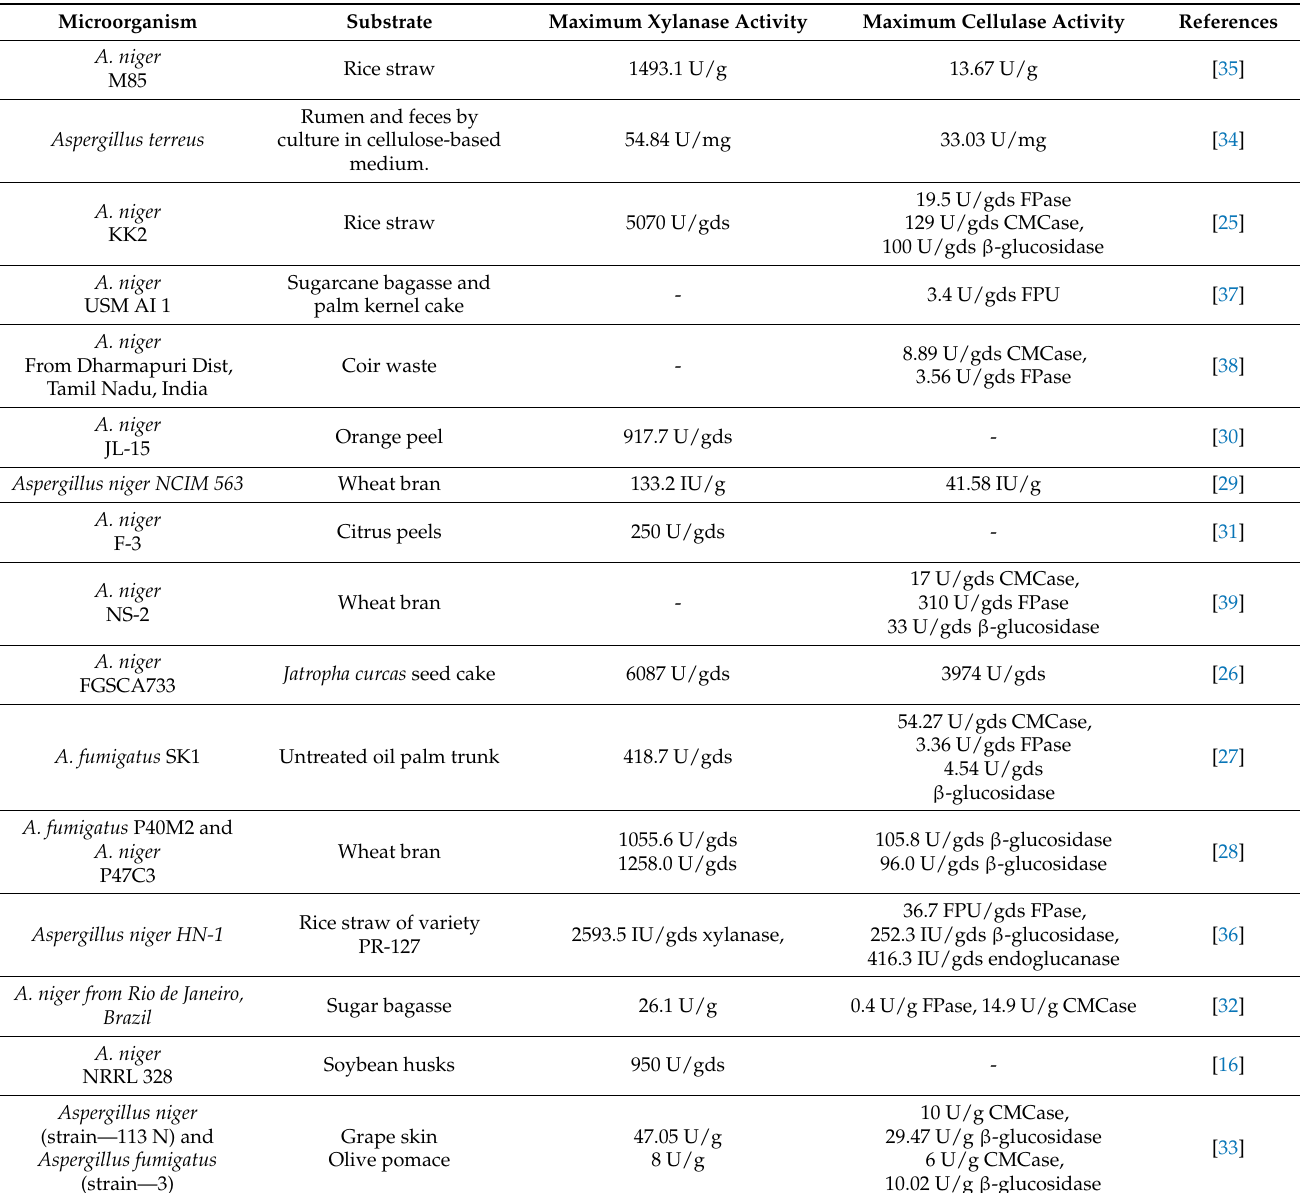
Table 2. Comparison of cellulase and xylanase production by other Aspergillus